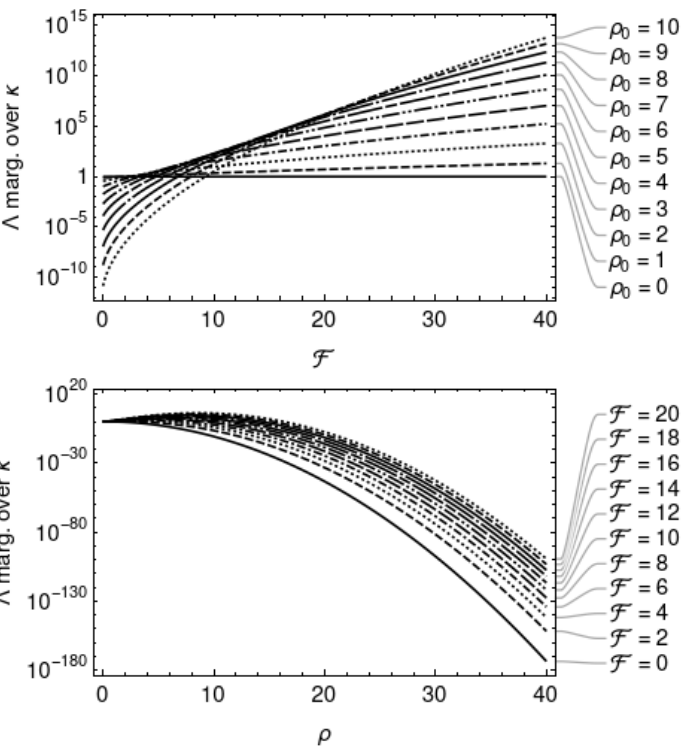
Figure 2. The likelihood ratio marginalised over κ (Equation (19)). Top: as a function of values of ρ . Bottom: as a function of ρ for fixed values of